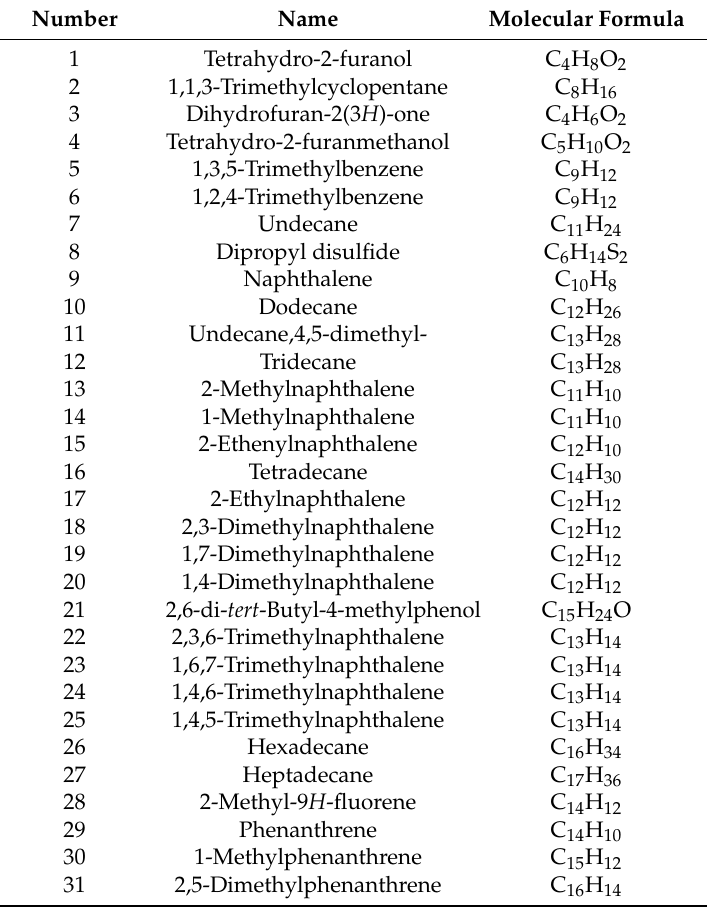
Figure 4. Total ion chromatogram (TIC) of the THF extract of TFF coal samples. Table 3. TFF tetrahydrofuran extraction GC/MS analysis results.